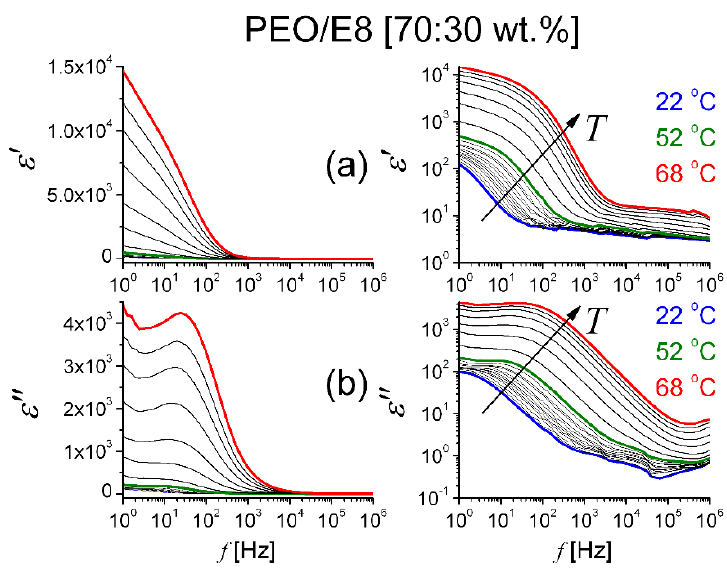
Figure 8. Frequency spectra of real ( a ) and imaginary ( b ) parts of complex dielectric permittivity for PEO/E8 at various temperatures. Data for ε presented in linear ( left ) and logarithmic ( right ) scale. The arrows show the effect of increasing temperature.